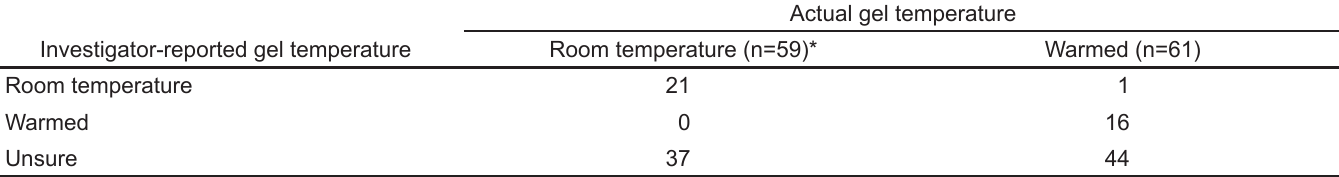
Table 3. Blinding efficacy.